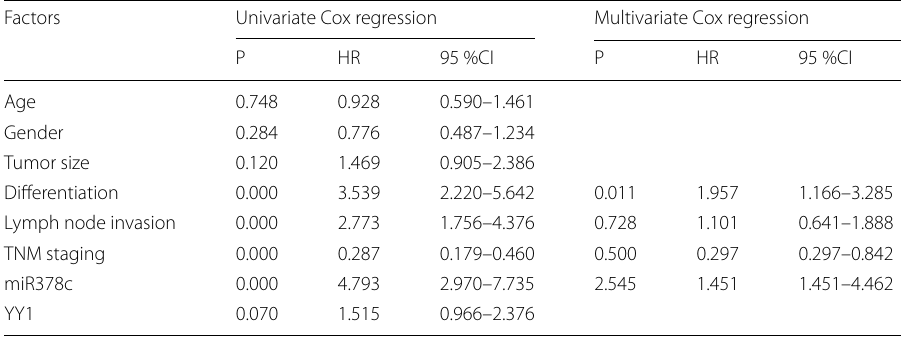
Table 2 Prognostic factors of gastric cancer